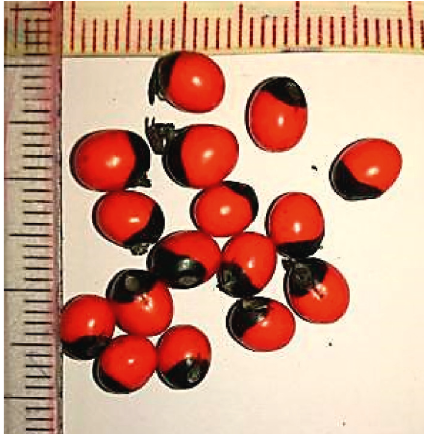
Figure 2: A.precatarius seeds, from a plant in the patient’s